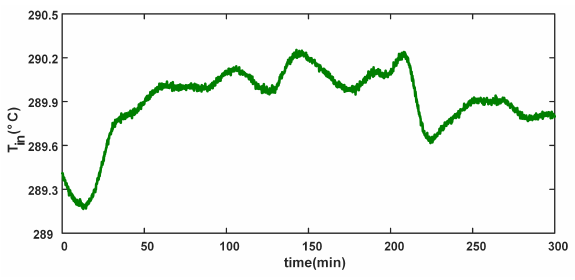
Fig. 4. Inlet temperature curve of the collector field.